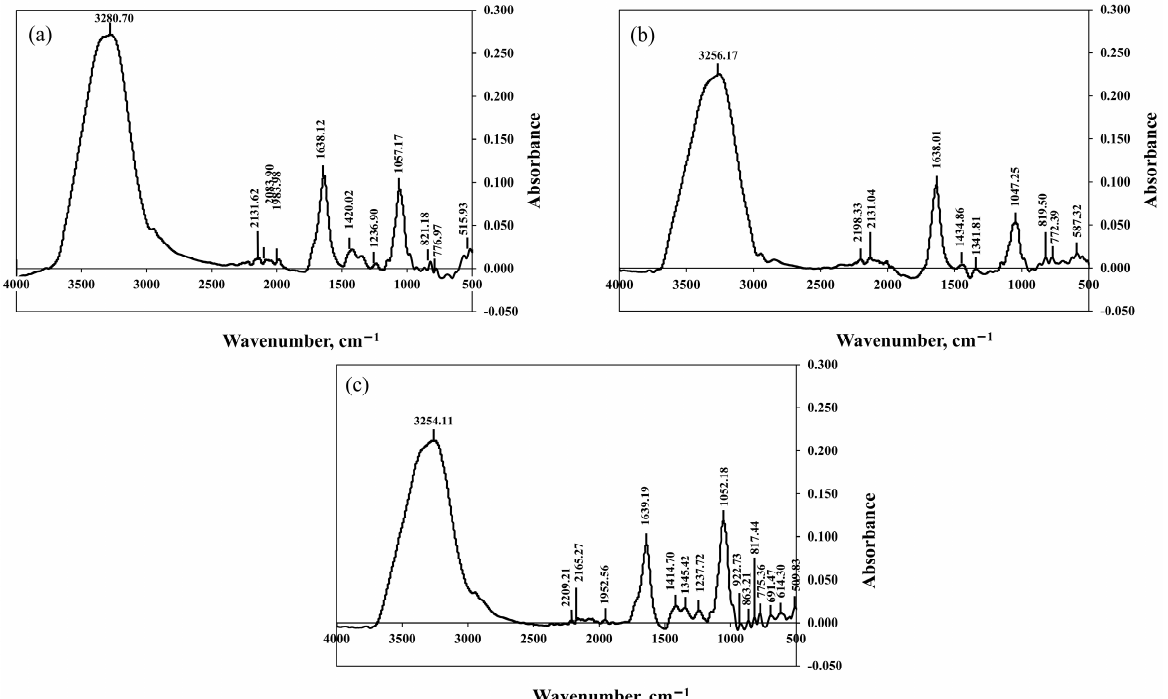
Figure 4. Fourier transform infrared (FTIR) spectra of plum wine using S. cerevisiae var. burgundy ( a ), H. thailandica Zal1 ( b ), and EC1118 ( c ).